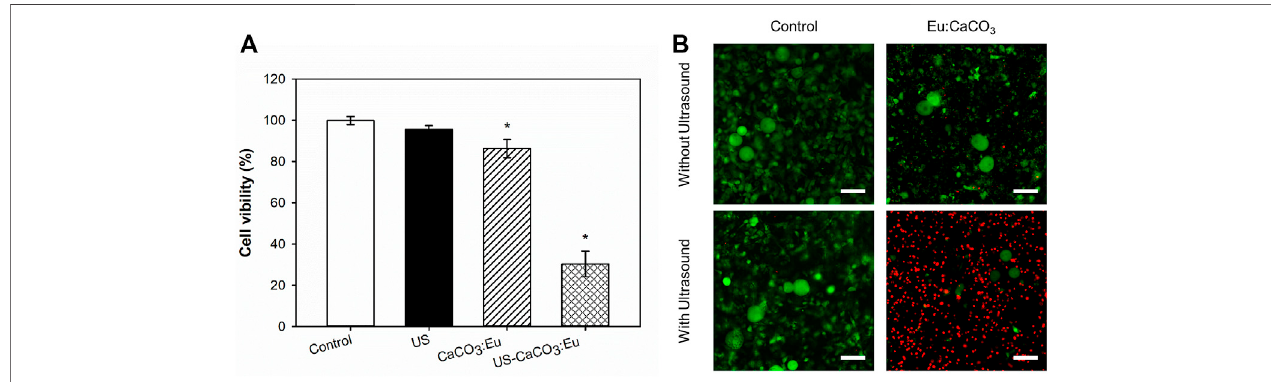
FIGURE 9 | The cell viability of CaCO 3 : Eu exposed to ultrasound stimulation, evaluated by (A) WST-1 assay, * p < 0.05, and (B) Live/dead staining (scale bar: 100 μ m).